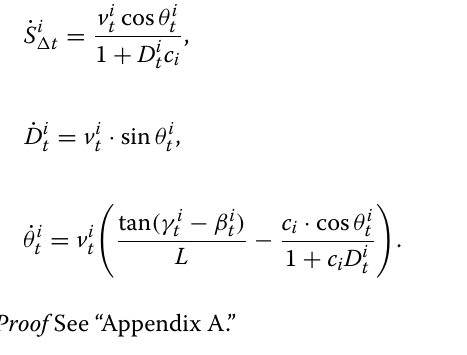
˙ S i of curvature. (cid:31) t is the further projection by considering the lateral deviation